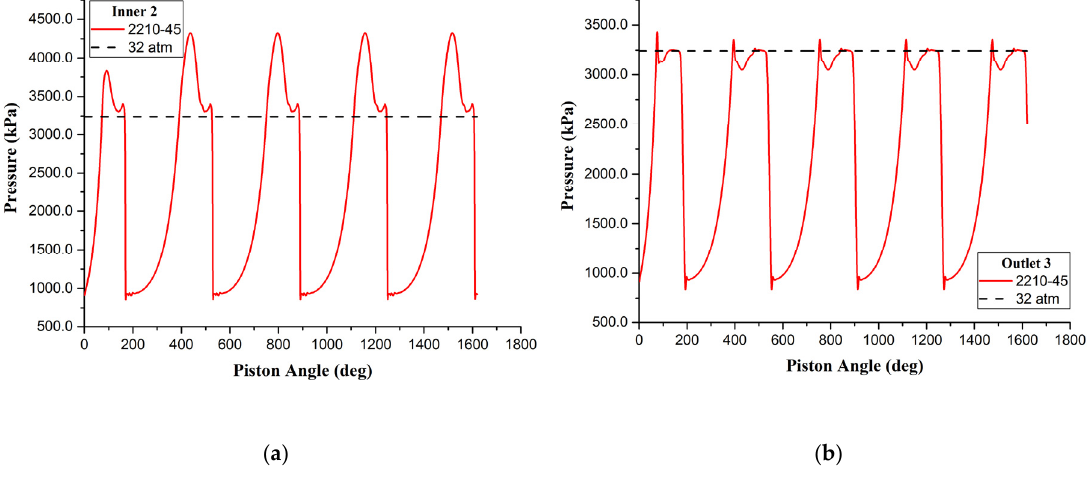
Figure 8. Pressure variation during a serial of cycles: ( a ) pressure of compression chamber measured at Inner 2, ( b ) discharge pressure measured at Outlet 3.